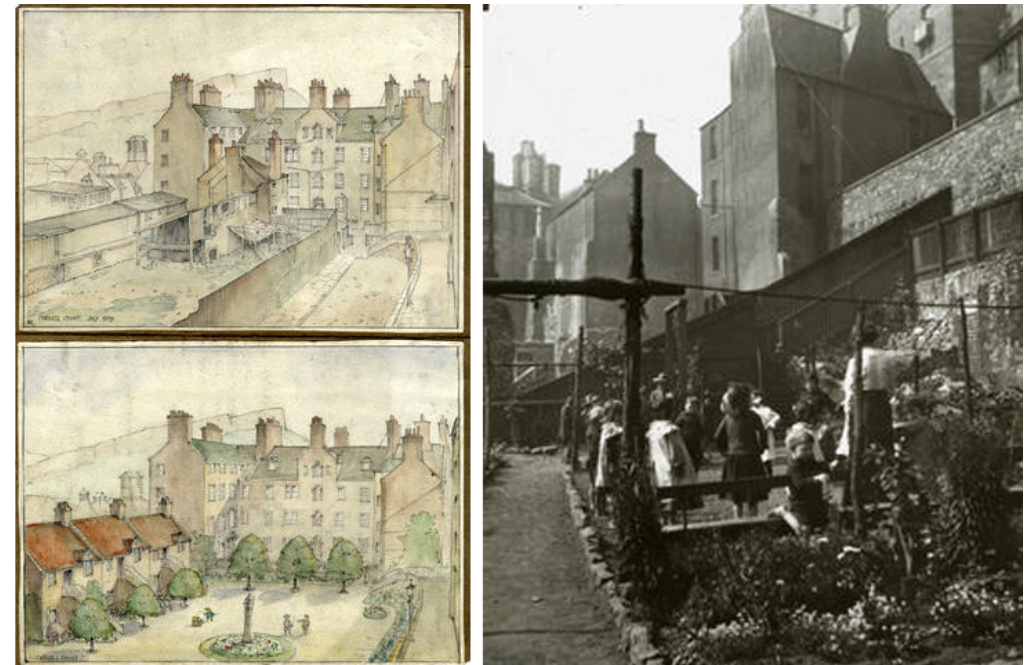
Figure 2. Repairings of Edinburgh Old Town Tenements, 1911. Photograph by Patrick Geddes and drawings by Nora Mears. Source: Patrick Geddes Papers (n.d.).